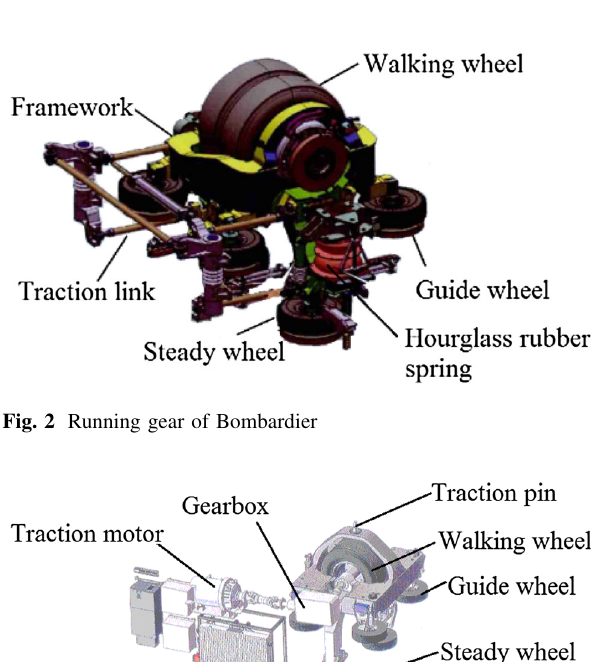
Fig. 3 Running gear of